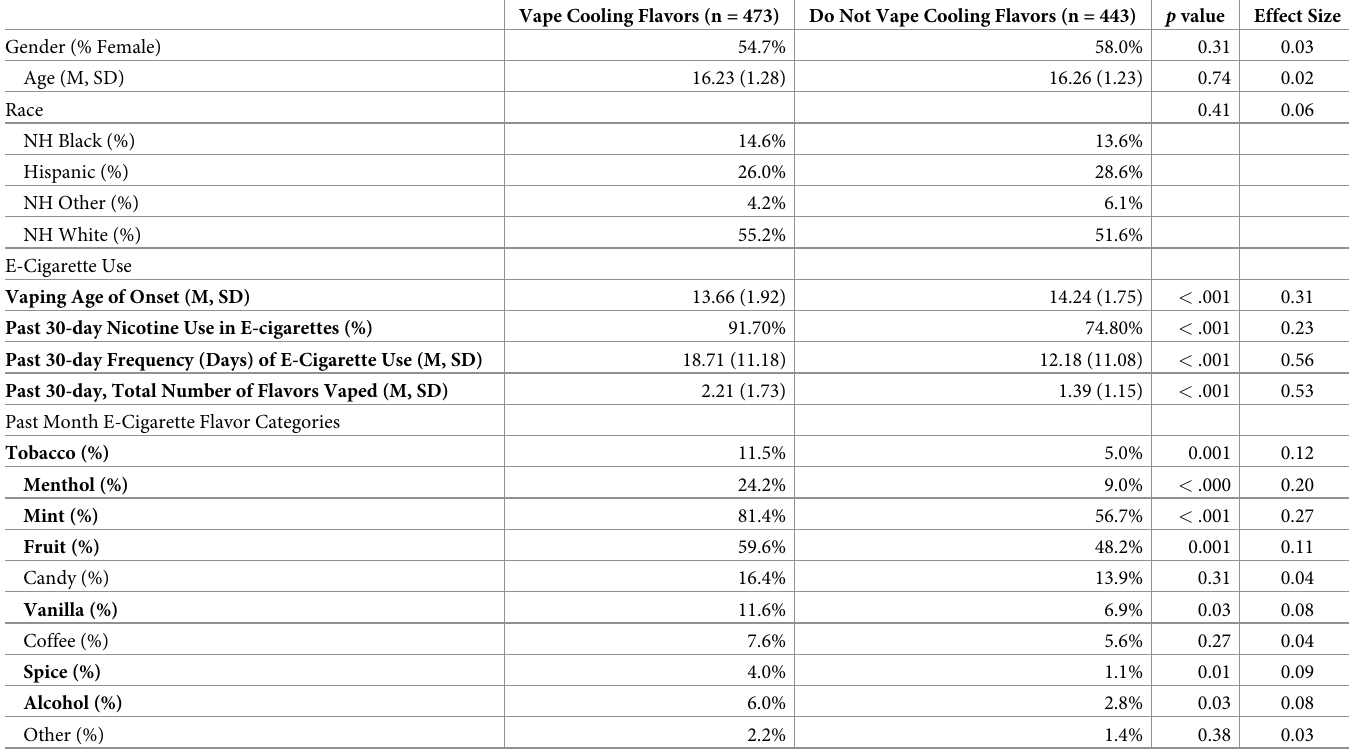
Table 1. Demographic and e-cigarette use of youth who do and do not vape cooling flavors.